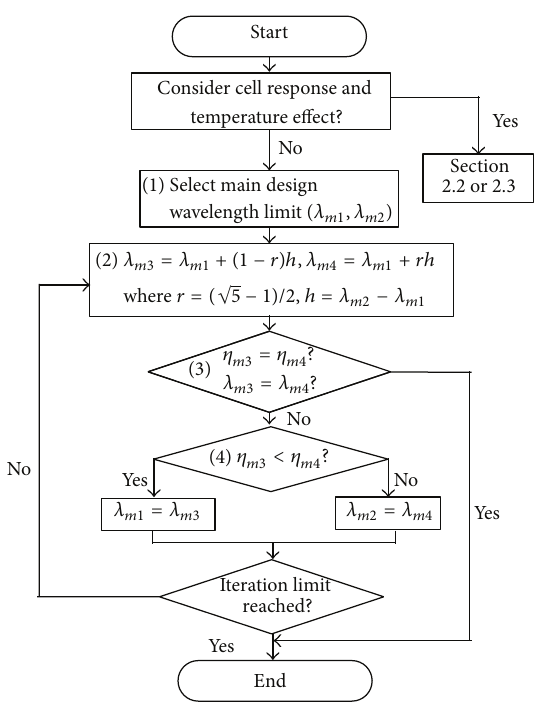
Figure 4: Flow chart of golden section search method for calcula- tion of the main design